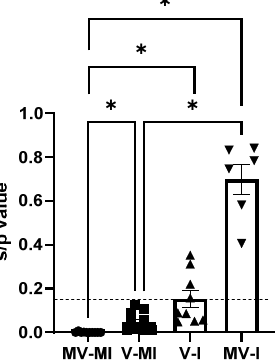
Figure 8. Serum sample to positive value ( s / p ) at 14 dpi. The bars represent mean; the geometric figures, the individual values; and the error bars, the standard error of mean (SEM). The horizontal discontinuous line represents the cut-off value of negative to positive serological diagnostic results, corresponding to 0.15. Kruskal–Wallis test followed by Dunn’s multiple comparison test was used to compare the group differences. * = p < 0.05.